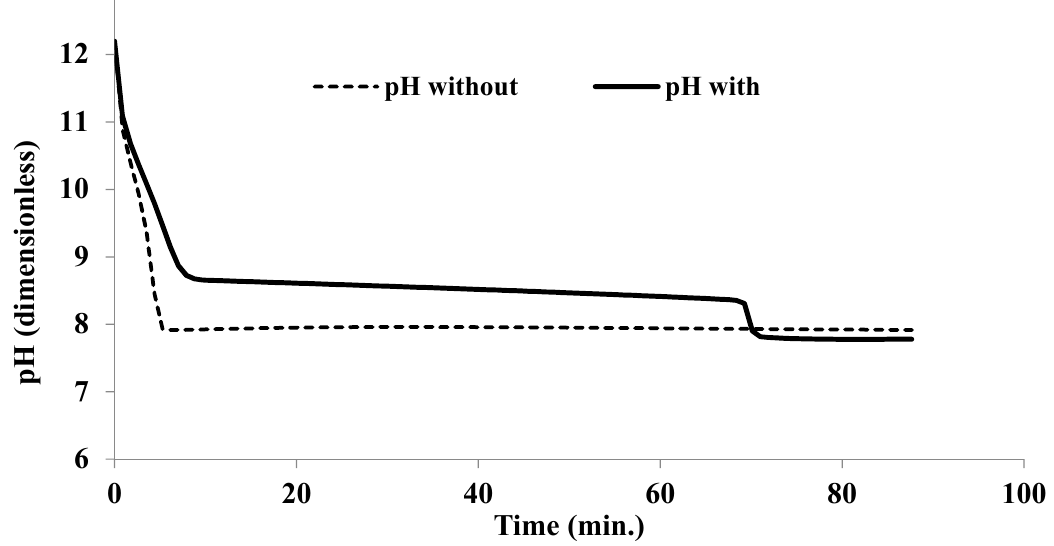
GBIG present. This ratio is equal to the stoichiometric ratio, Equation (1), with GBIG pre- sent while it is smaller without. After consumption of GBIG the system reverts to the be- havior without GBIG. Figure 3. Time evolution of amino acid compounds in liquid phase, red with GBIG present, black without